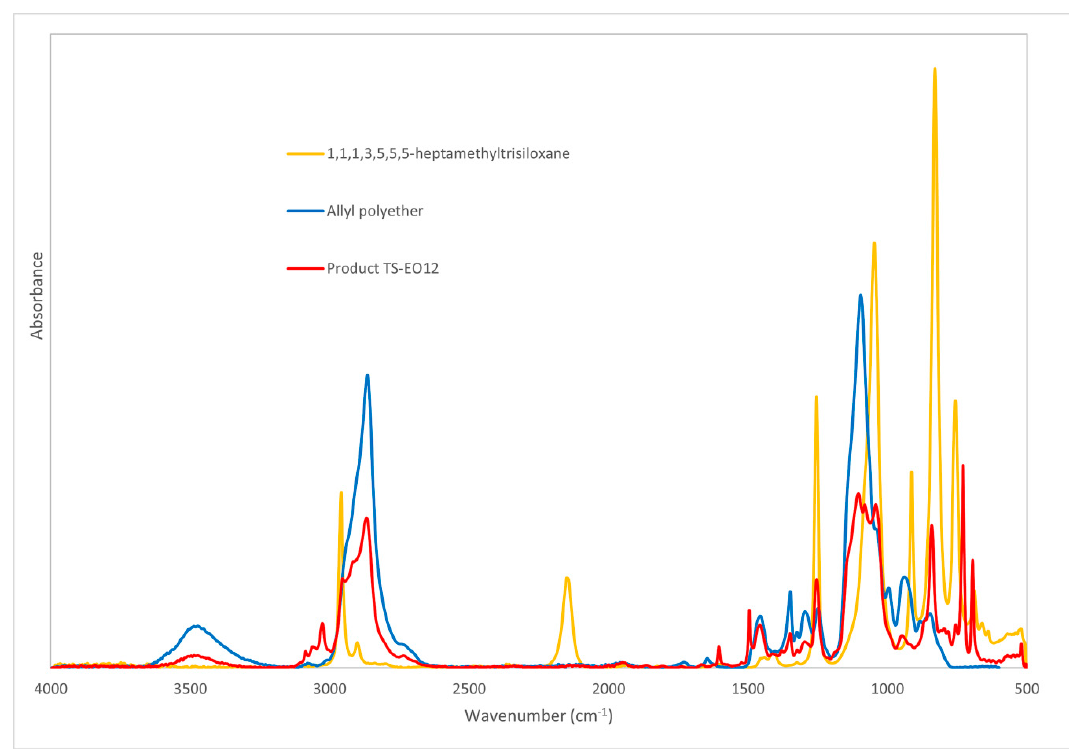
Figure 6. 29 Si-NMR spectrum of the product.